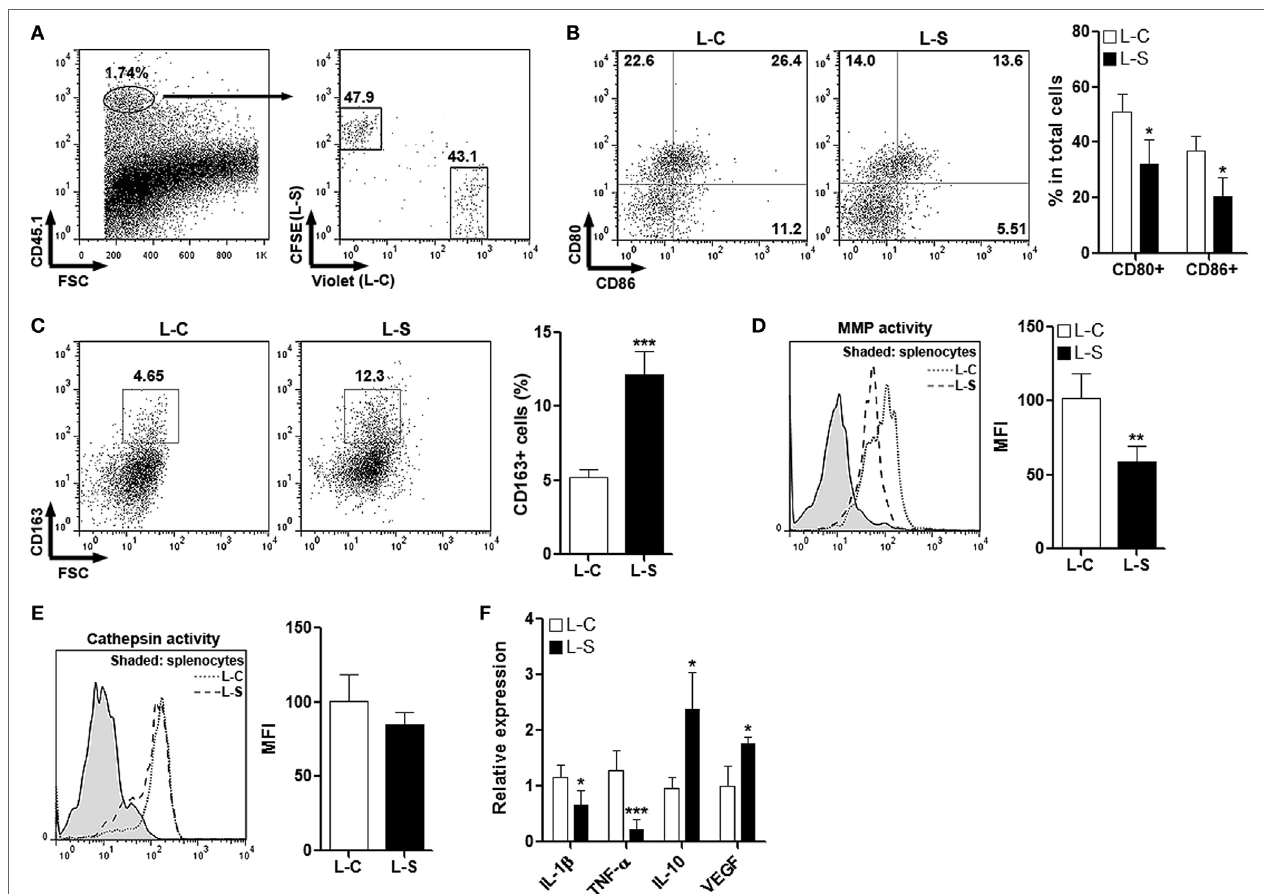
FigUre 3 | Ectopic Sestrin2 expression in M1 macrophages inhibits pro-inflammatory response in vivo . (a) Detection of adoptively transferred M1 macrophages in infarcted myocardium at day 3 after myocardial infarction. Note that M1 macrophages were derived from C57BL/6.SJL mice, transduced with lentivirus (L-C or L-S, respectively), and labeled with CellTrace Violet or carboxyfluorescein succinimidyl ester (CFSE) before adoptive transfer. Numbers in the plots are proportions of gated cells populations. (B) Expression of CD80 and CD86 on transferred M1 macrophages. Left panel: representative dot plots. Right panel: statistics. L-C: M1 macrophages transduced with control lentivirus. L-S: M1 macrophages transduced with SESN2 lentiviral activation particles. (c) Expression of CD163 on transferred M1 macrophages. Left panel: representative dot plots. Right panel: statistics. (D,e) MMP activity (D) and Cathepsin activity (e) in transferred M1 macrophages. Left panel: representative histograms. Right panel: statistics. (F) mRNA abundance of indicated cytokines in transferred M1 macrophages. N = 4–6 per group. * p < 0.05; ** p < 0.01; *** p < 0.001 in comparison with